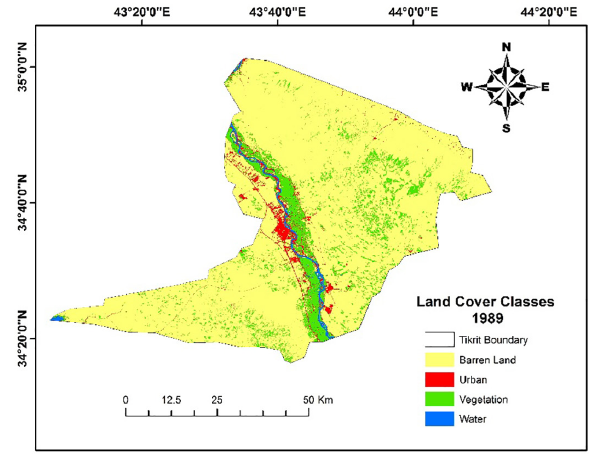
Figure 4. Classified map of LULC, 2002